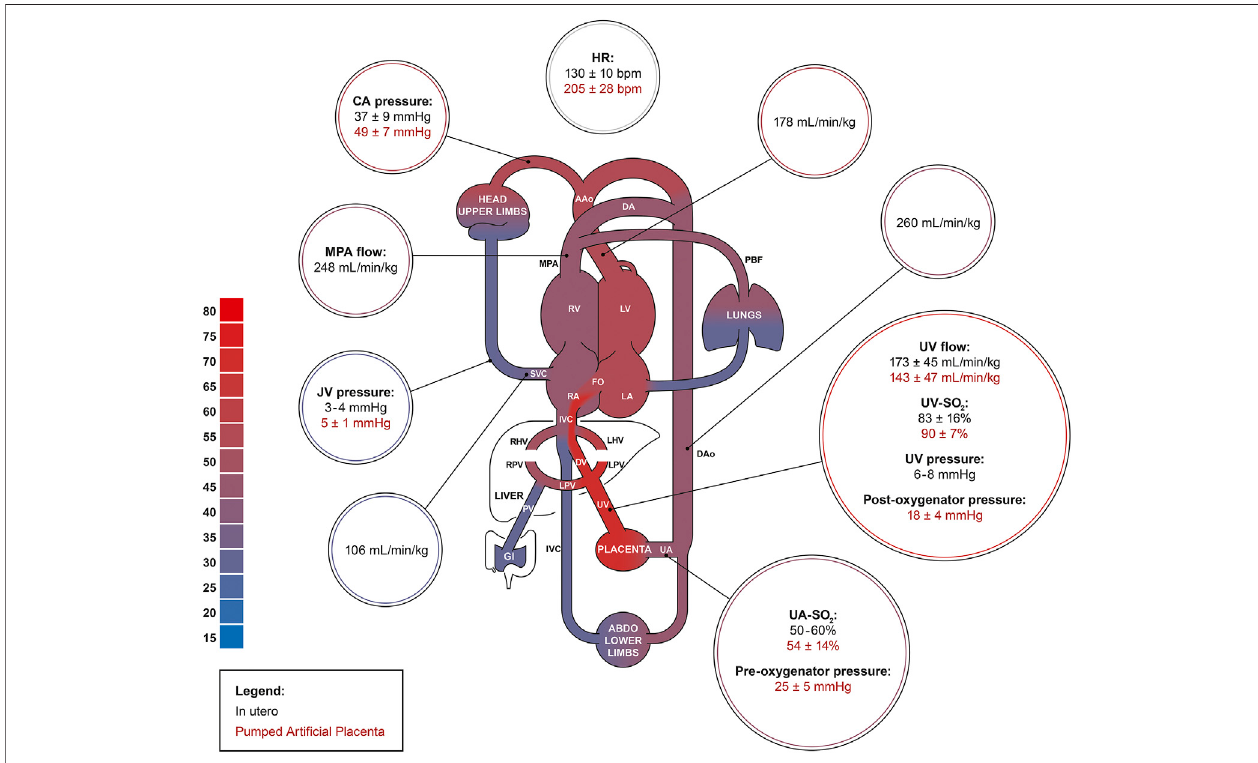
FIGURE 9 | The fetal pig circulation. Comparing physiologic in utero values (black; n = 61) to data acquired from the pumped AP experiments (red). Physiologic in utero data was acquired from Rudolph et al., Acharya et al., Charest-Pekeski et al., and Berman et al. (Rudolph and Heymann, 1970; Berman et al., 1976; Rudolph, 2009; Acharya et al., 2016; Charest-Pekeski et al., 2021).